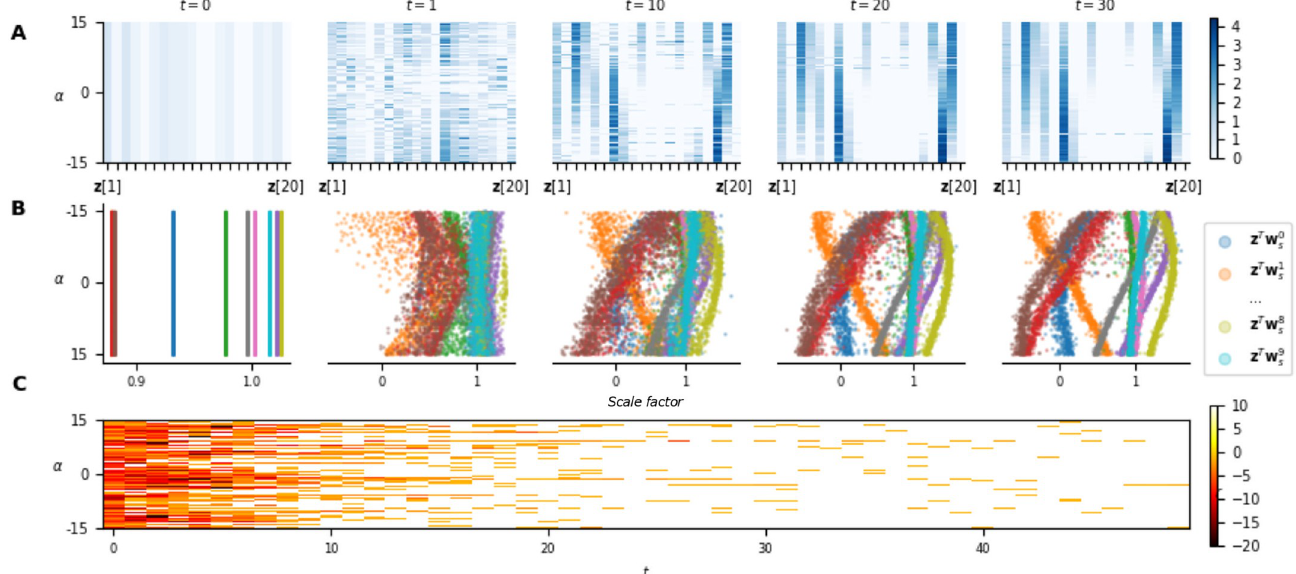
Fig 7. Adaptation capabilities of the NMN architecture on benchmark 1. A . Temporal evolution of the neuromodulatory signal z with respect to α , gathered on 1000 different episodes. Note that the neuromodulatory signals go from uniform distributions over all possible α values (i.e., the different contexts) to non-uniform and adapted (w.r.t. α ) distributions along with an increase in the rewards. B . The value of the scale factors with respect to α for each neuron of a hidden layer in the main network. C . Rewards obtained at each time-step by the agent during those episodes. Note that light colours represent high rewards and correspond to adapated neuromodulatory